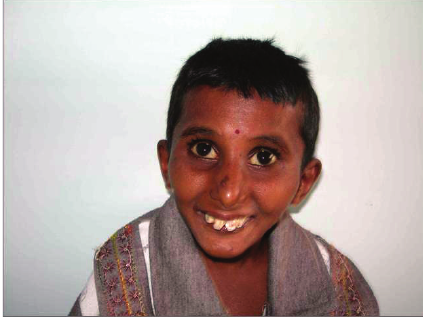
Figure 2: It shows the face of the 9-year-old boy showing typical features of progeria.